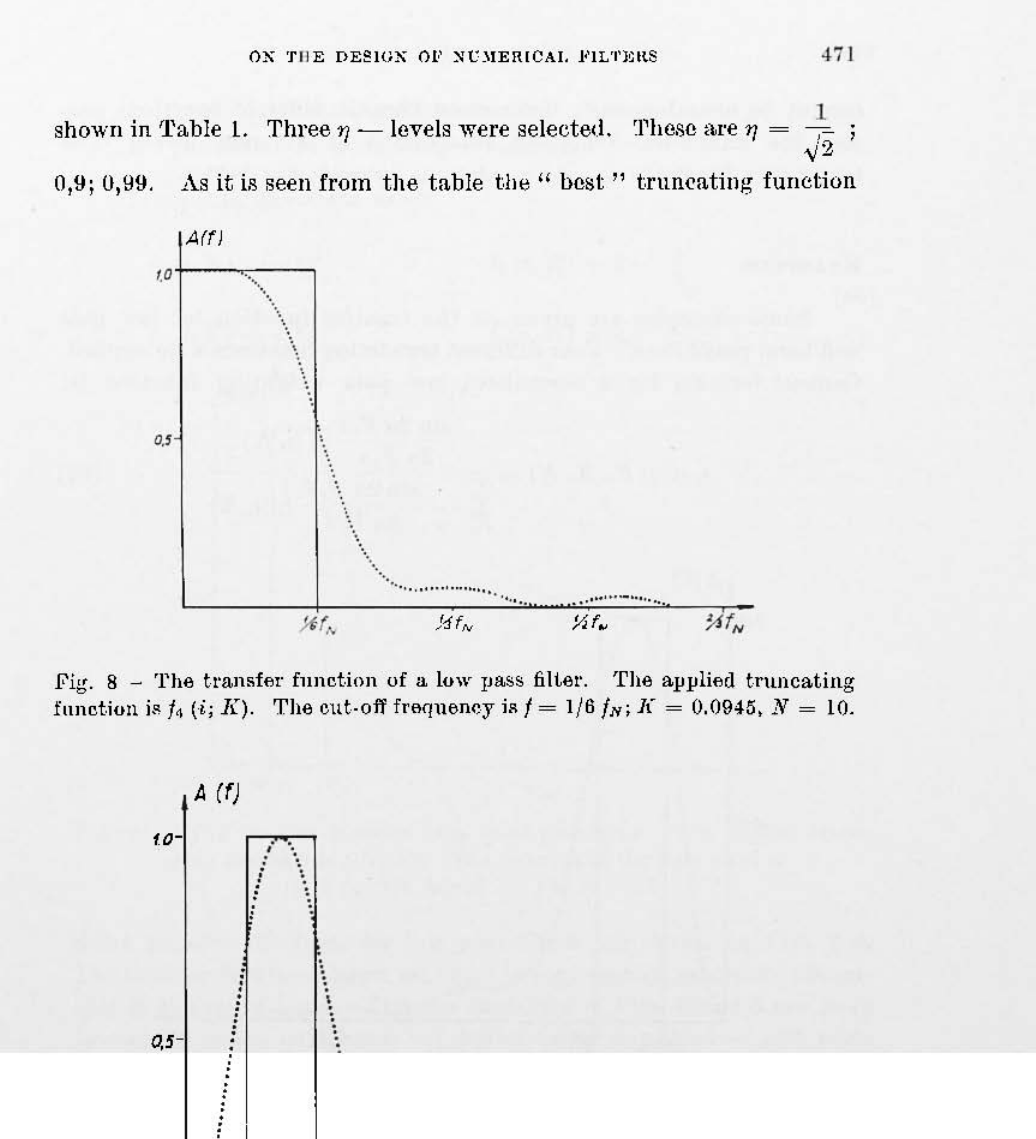
Fig. 8 - 'l'he tmnsfer fllnction uf a luw pass